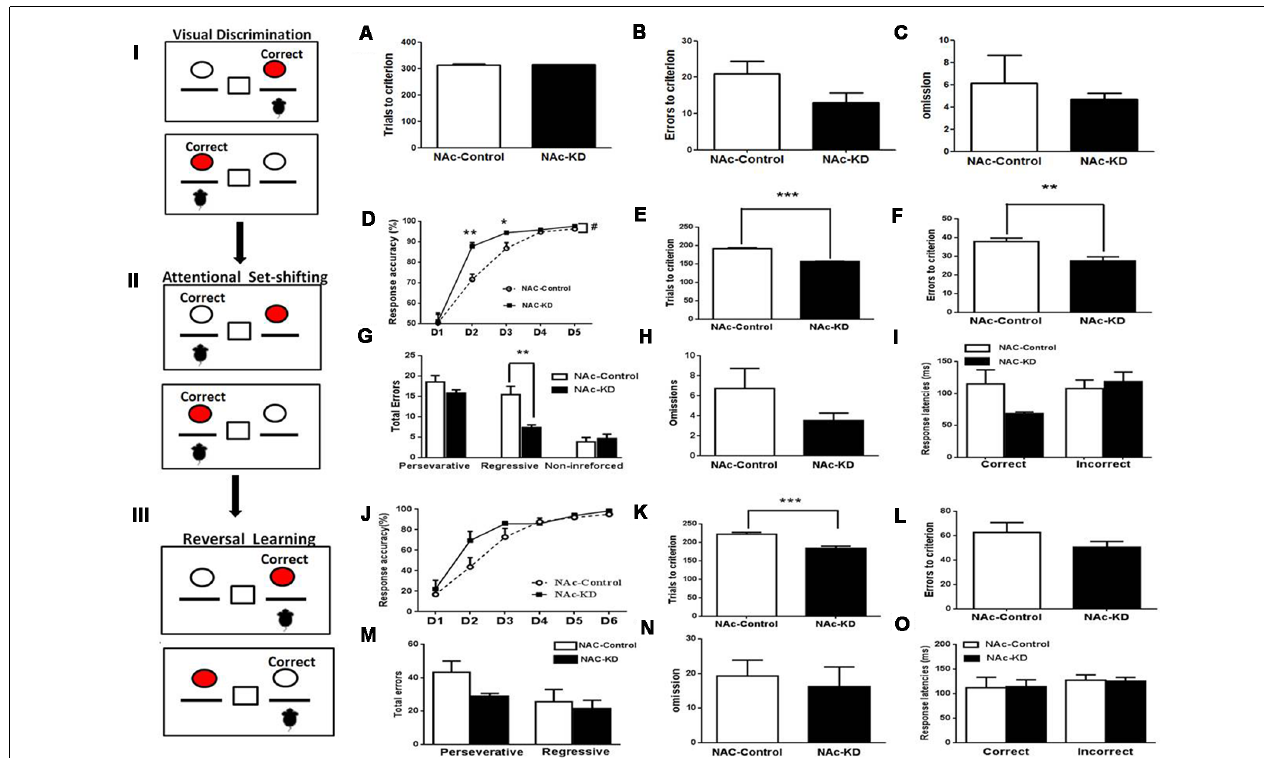
FIGURE 2 | NAc A 2A R KD did not affect visual discrimination but facilitated attentional set-shifting and reversal learning. (Left panels I, II, III) A schematic illustration of mouse operant cognitive flexibility task. (A–C) The NAc A 2A R blockade did not affect the performance of visual discrimination (total number of trials needed to reach the criterion: p > 0.05; total number of errors, p = 0.1164; total number of omission, p = 0.637, Student’s t -test) compared with the control group. (D–I) A 2A R KD in the NAc facilitated attentional set-shifting by decreasing regressive errors. (D) A two-way repeated measures analysis of variance (ANOVA) showed that both groups increased their correct response ratio along with increasing sessions (main effect of training session, F ( 4,44 ) = 124.187, p < 0.001), but the correct response ratio in the A 2A R-KD group increased faster than the control (group effect of group, F ( 1,11 ) = 10.123, p = 0.009). This group effect interacted with the training sessions (group × session interaction, F ( 4,44 ) = 3.819, p = 0.035). (E,F) The number of the trials and errors needed to reach the criterion also differed between the two groups ( Figure 2E , trials, p < 0.05; Figure 2F , errors, p < 0.05). There was a significant effect of the NAc A 2A R KD ( Figure 2G , F ( 1,30 ) = 8.189, p < 0.001) and the NAc A 2A R KD × error type interaction ( Figure 2G , F ( 2,30 ) = 4.565, p = 0.0186). Multiple-comparison analysis indicated that NAc A 2A R KD decreased the regressive errors ( p < 0.05) but had no effect on the perseverative errors and non-reinforced errors ( Figure 2G , both p > 0.05). The omissions and correct response latencies showed a decreasing tendency but failed to reach statistical significance after NAc A 2A R KD ( Figure 2H , omissions, p = 0.1865; Figure 2I , correct response latencies, p = 0.0622). (J–O) NAc A 2A R KD improved reversal learning. (J) Response accuracy analysis revealed the session-dependent learning rates across both groups ( F ( 4,44 ) = 99.01, p < 0.01), but there was no group difference ( F ( 1,11 ) = 0.679, p > 0.05, first 5 days) and group × session interaction effect ( F